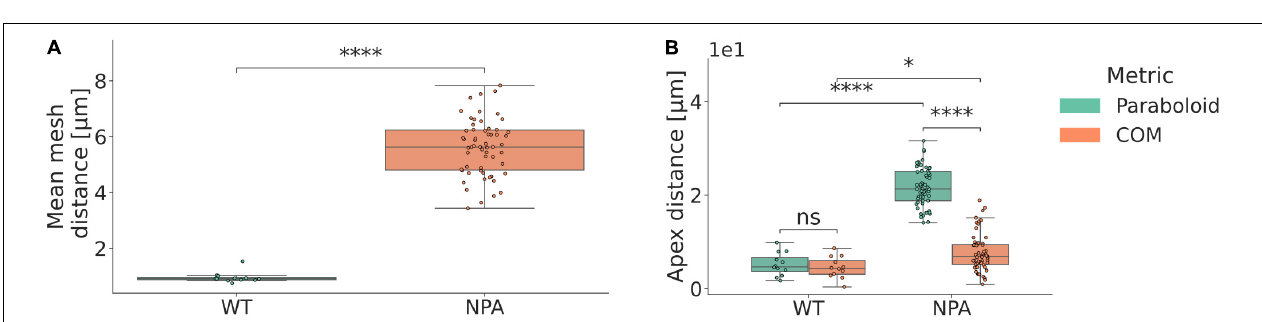
FIGURE 1 | A low-resolution tolerant surface quantification framework. (A–F) Example illustration of the quantification framework, showing the fundamental stages illustrated by the (A) raw confocal intensity data after acquisition, (B) intensity data after pre-processing, (C) contour after post-processing, (D) mesh after post-processing, (E) vertex curvature after post-processing, and (F) segmentation after post-processing. (A) is a summed intensity projection, (B,C) are 3D volume renders of the data, (D–F) are 2.5D surface meshes encapsulated in 3D space. Scale bar: 75 µ m. Scales in (B–F) further to (A) . Colouring in (A,B) and (E) shows the corresponding value magnitude in arbitrary units, whereas (C,D) are false-coloured, and (F) is coloured by integer label value. A detailed description of the protocol is provided in Methods and further illustrated in Supplementary Figure 1 . (G) Mean error for the closest vertex on the downscaled mesh for every vertex in the high-resolution mesh. The error increases more rapidly with decreasing resolution in XY relative to that of Z as the X and Y dimensions are altered synchronously.